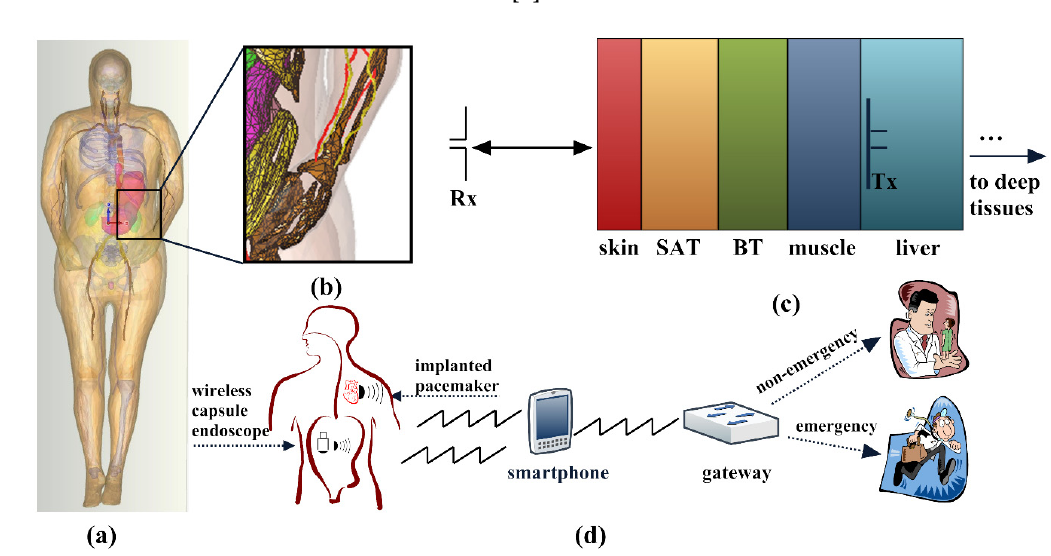
Figure 2. ( a ) The computational 3D human body model in CST; ( b ) the cross section of the human frontal thorax; ( c ) equivalent human frontal thorax model; ( d ) typical healthcare applications.